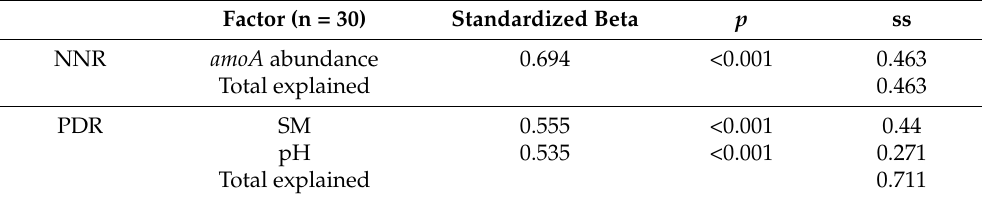
Table 2. Results of multiple regression analyses applied to data obtained from all N treatments to evaluate the relative importance of microbiological and environmental factors for the net nitrification activities (NNA) and potential denitrification activities (PDA).